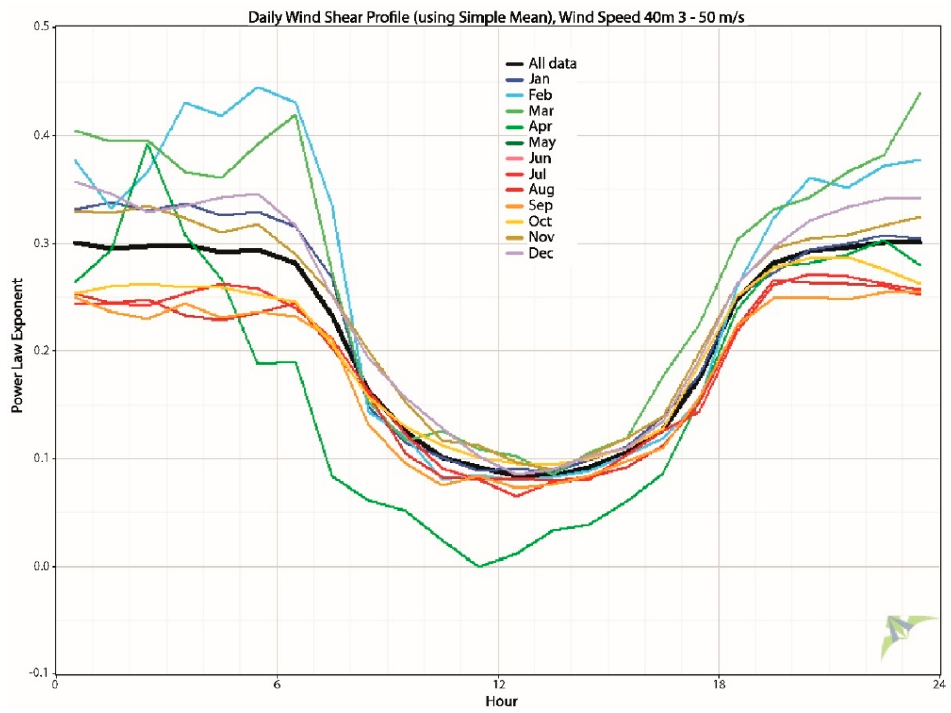
Figure 11. Alpha coefficient, according to the month of the year and time of day. Source: generated by the software.